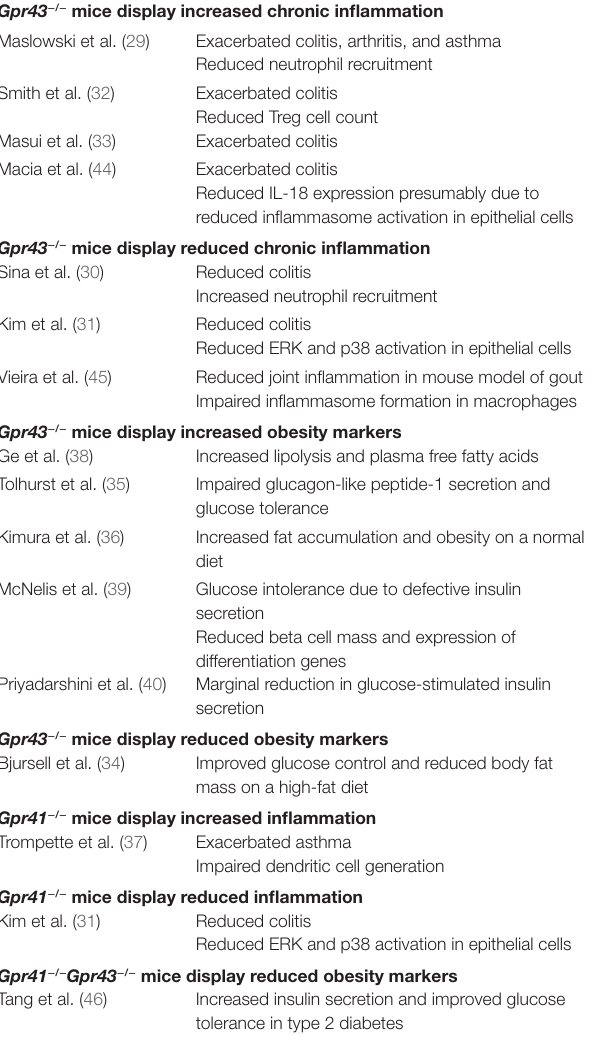
TABLe 1 | Contradictory findings on the inflammation phenotypes of Gpr43 − / − and Gpr41 − / −